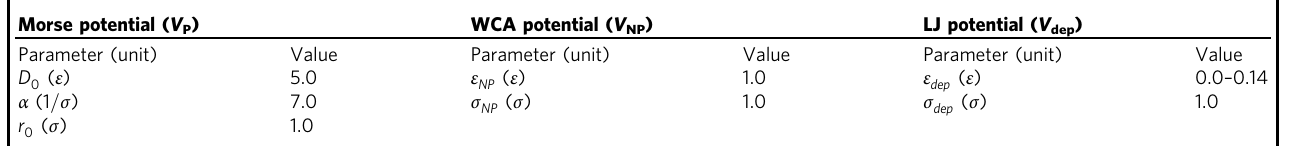
Table 1 Potential parameters for the MD simulation Morse potential ( V P